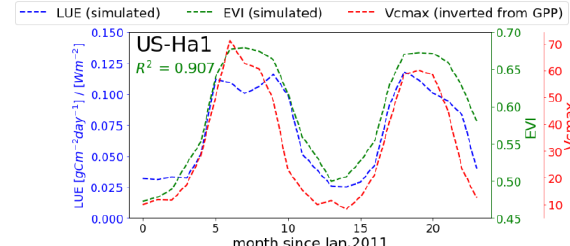
Figure 5. Simulated EVI and LUE seasonal cycles for US-Ha1 site with Vcmax inverted from GPP. R2 is the coefficient of determination between monthly EVI and LUE.part of the LUE variability can be explained by NIR-sensitive (red-edge-sensitive) VIs;